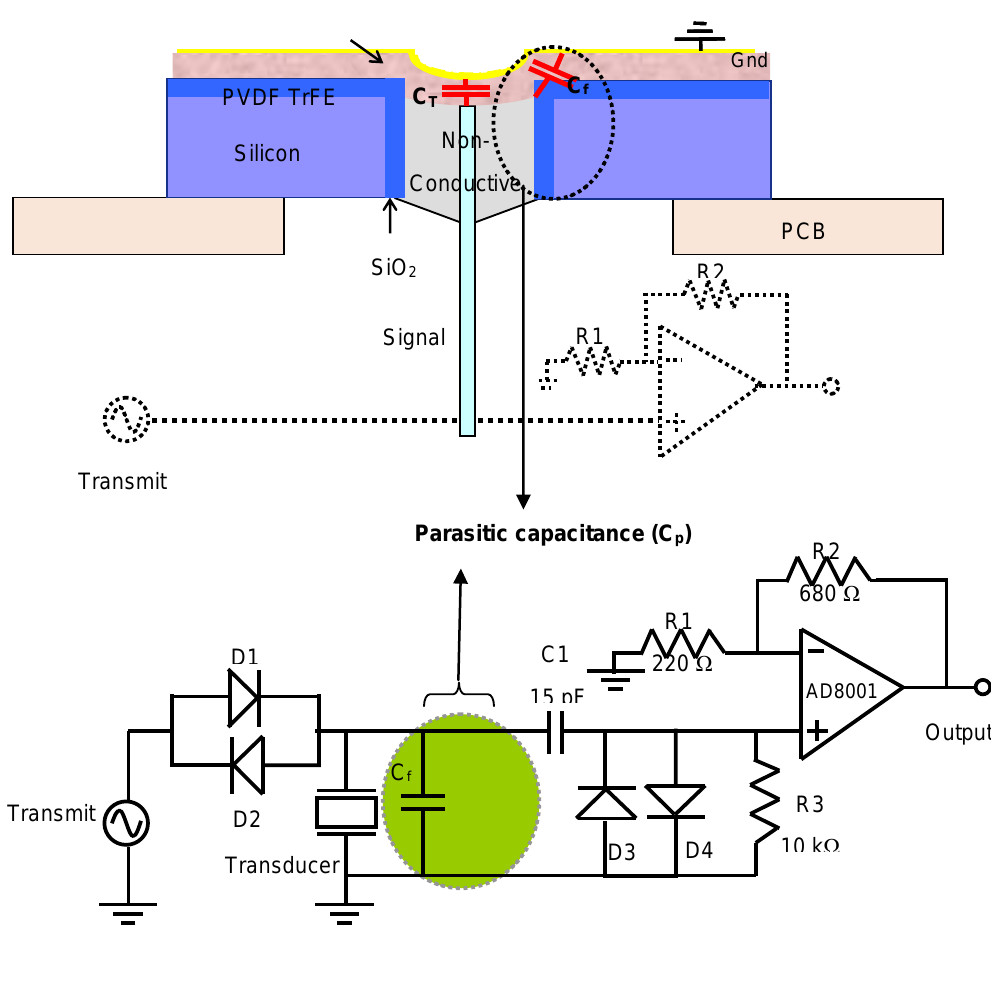
Figure 4. Cross-sectional and schematic of the suggested transducer model with minimal parasitic